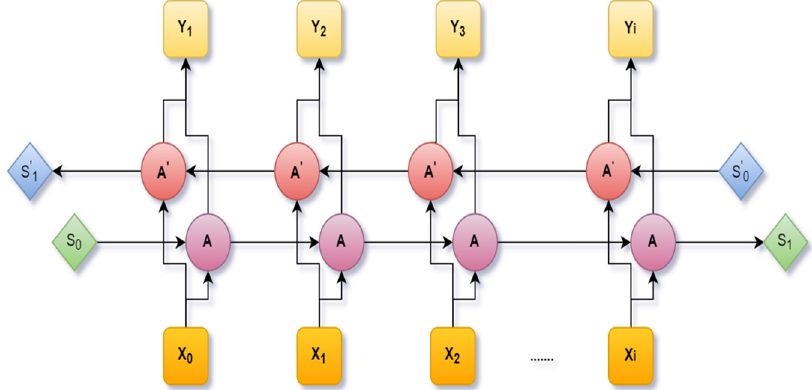
Figure 6. A bidirectional LSTM network.